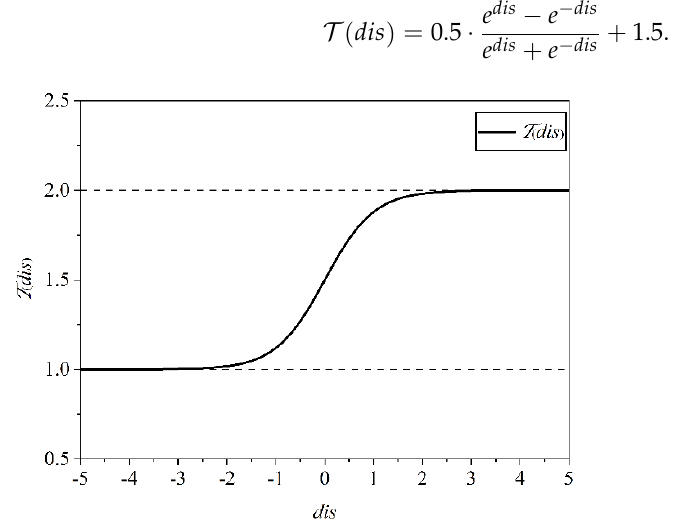
Figure 1. Image of the deformed tanh function.